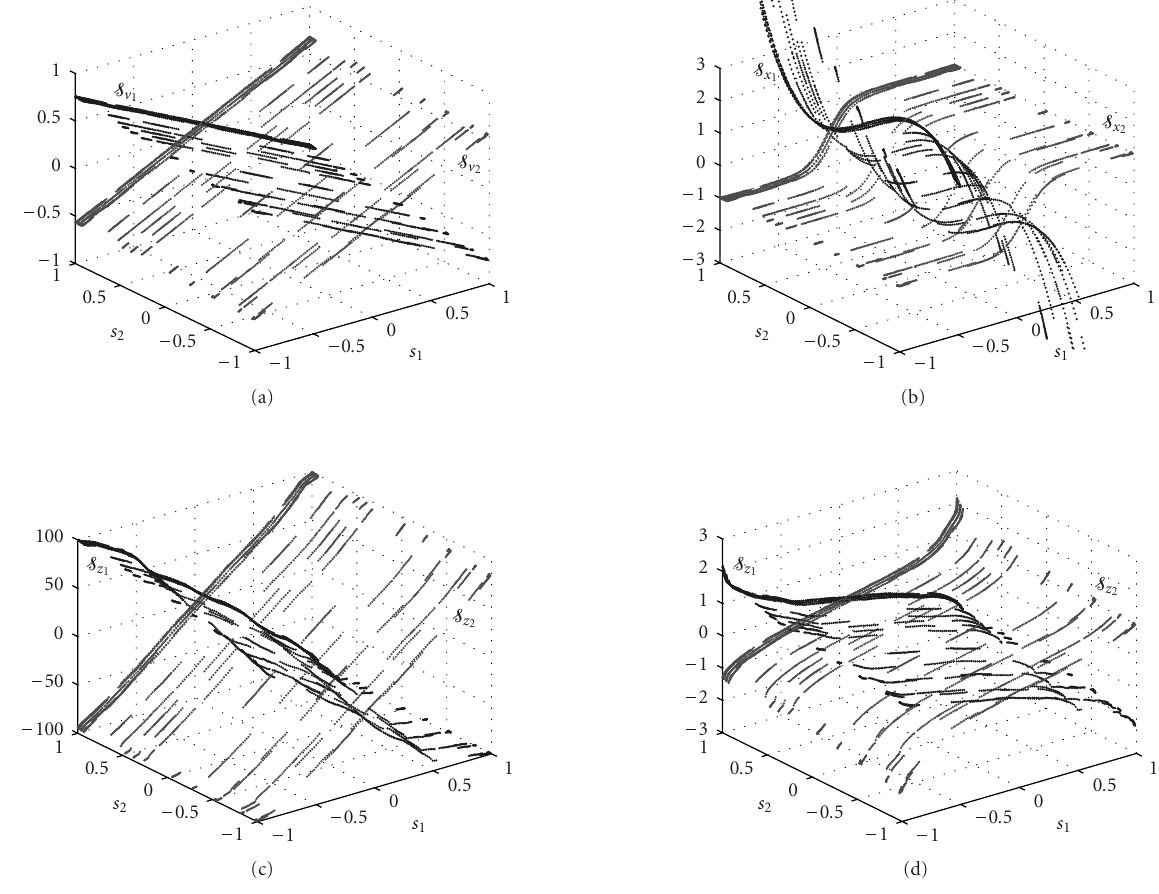
Figure 9: Geometric representation of signals in a 3D space. (a) Linear mixtures v 1 and v 2 . (b) PNL mixtures x 1 and x 2 . (c) gpICA’s linearized signals z 1 and z 2 . (d) Linearized signals using Gauss-TD.